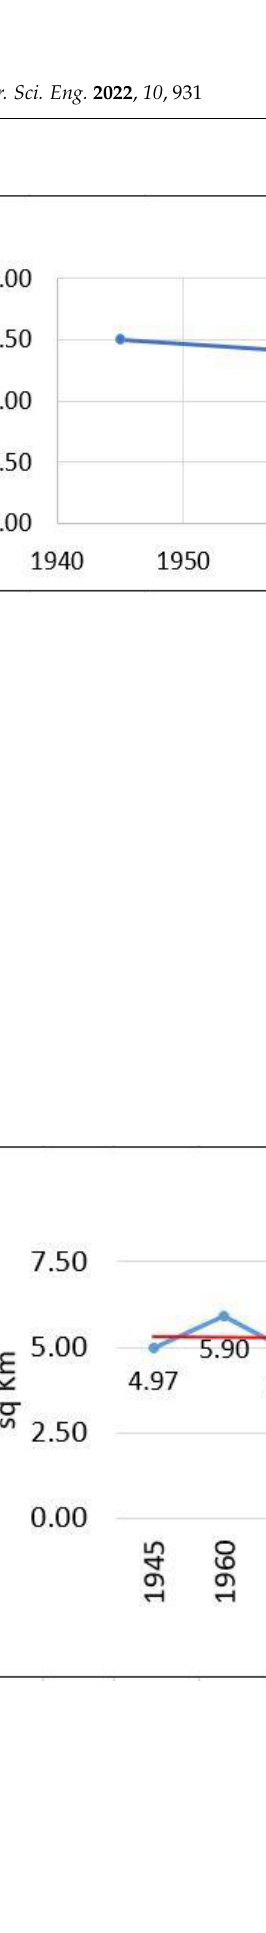
Figure 9. Lagoon’s perimeter fluctuati ons during the study period.